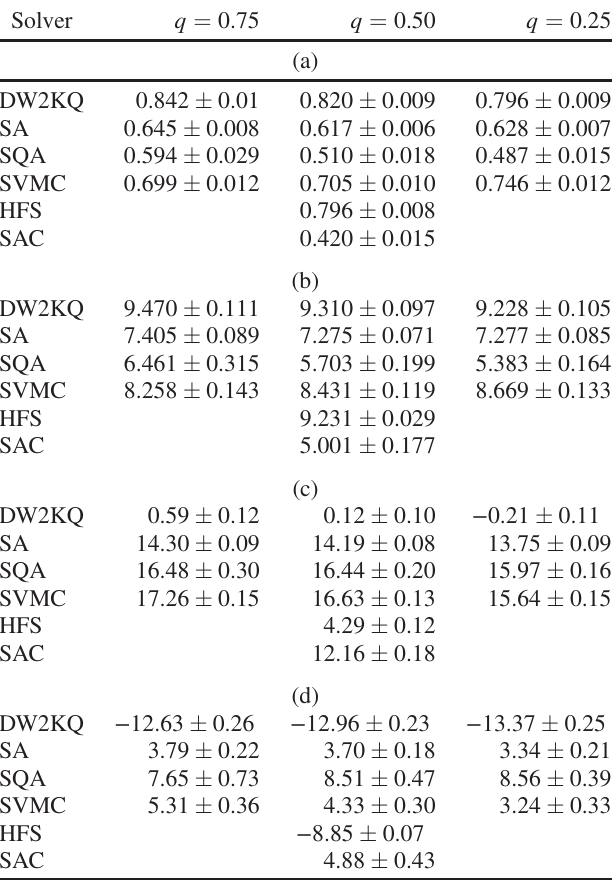
TABLE II. The coefficient b in fits to (a) exp ð a þ bL Þ and (b) exp ð a Þ L b and the coefficient a in fits (c) exp ð a þ bL Þ and (d) exp ð a Þ L b for the hardware-planted instances using L ∈ ½ 8 ; 16 (cid:2) . q denotes the quantile. Errors are 95% confidence intervals.